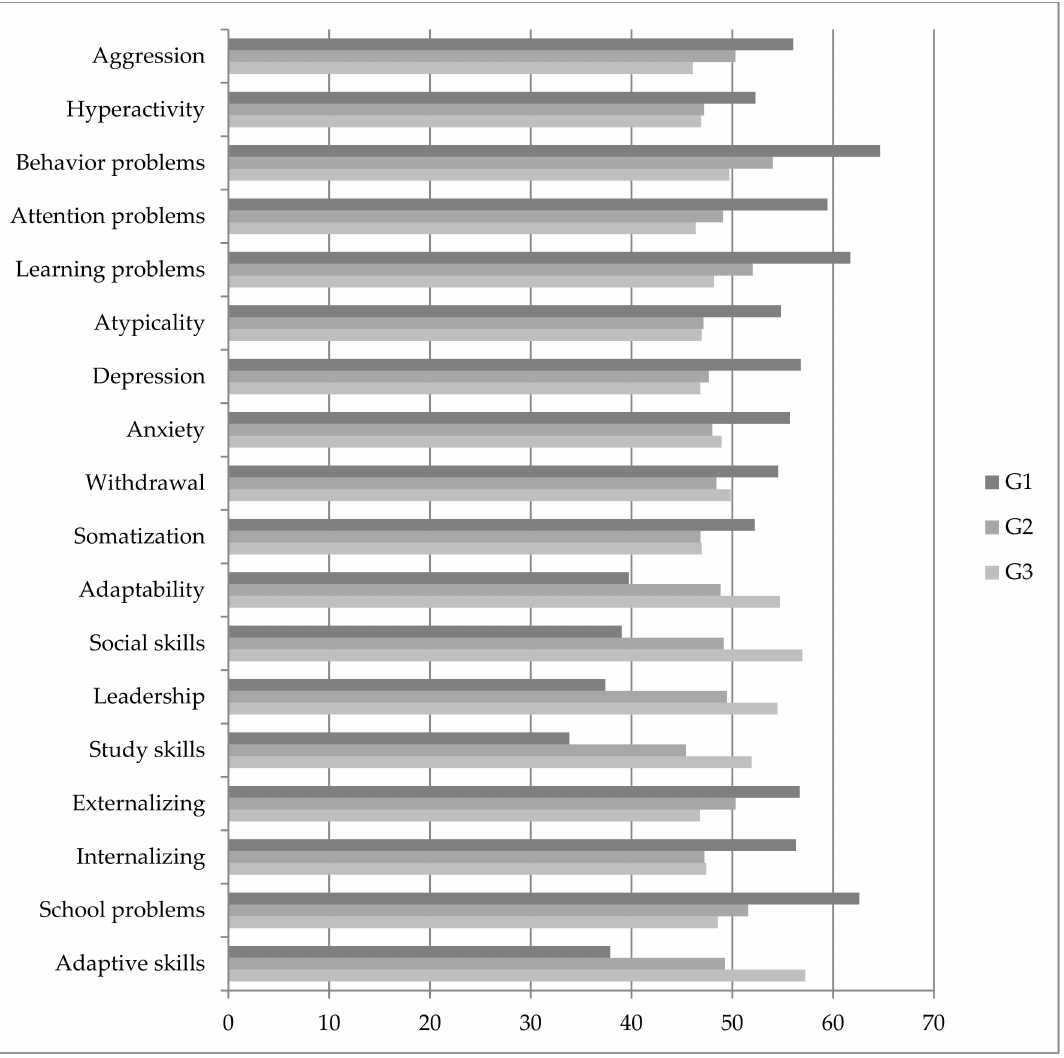
Figure 1. Average scores obtained by the three groups for the di ff erent dependent variables. All comparisons were significant for alpha =